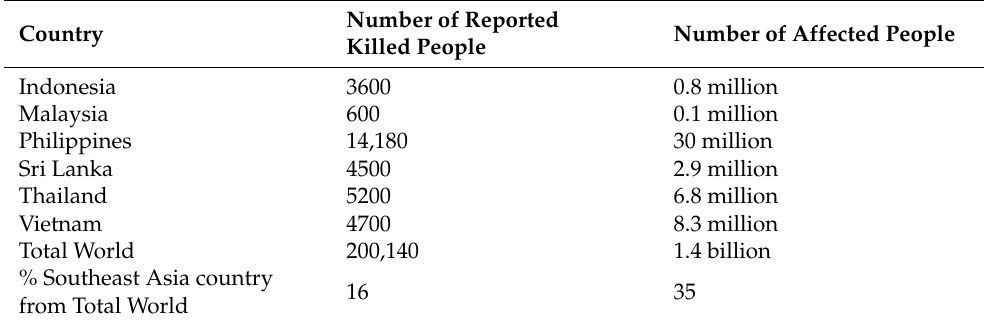
Table 1. Number of people killed or affected by coastal disasters in Southeast Asian countries between 2015 and 2020. Number of Country